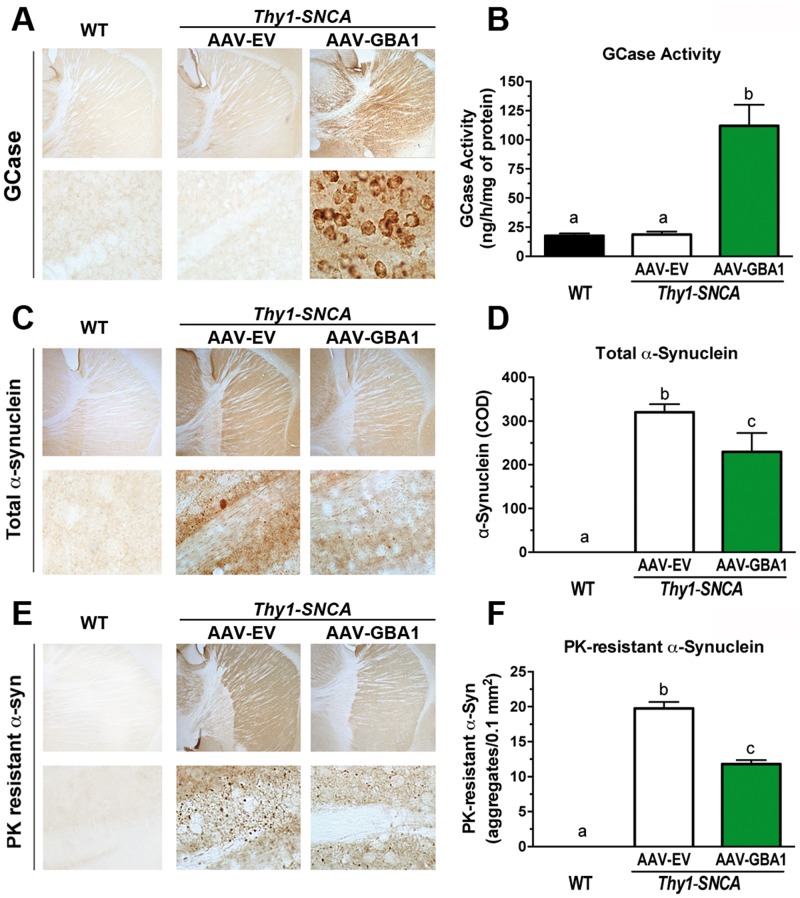
Administration of AAV1-GBA1 into the striatum of Thy1-SNCA transgenic mice reduces the levels of α-synuclein in the CNS. Two-month-old female Thy1-SNCA mice were subjected to bilateral striatal injections of 1.8e10 gc/site of either AAV1-EV (n = 16, white columns) or AAV1-GBA1 (n = 16, green columns). Uninjected, age-matched WT mice (WT; n = 16, black columns) were used as healthy controls. Tissues were collected for biochemical and pathological analysis at 7 months post-injection. Immunostaining for glucocerebrosidase showed robust striatal expression in AAV1-GBA1-injected Thy1-SNCA mice. Mice treated with a control virus (AAV1-EV) showed a low level of staining in the CNS that was similar in intensity to that in untreated WT mice. Representative pictures are shown in (A). Robust glucocerebrosidase activity was observed in AAV1-GBA1-injected striata (B, 6-fold greater than the AAV1-EV controls, n = 8 per group, p < 0.05). Increased glucocerebrosidase activity in the CNS of Thy1-SNCA mice reduced the levels of total and proteinase K-resistant α-synuclein levels. Representative photomicrographs of brain sections from the striata of WT and Thy1-SNCA mice immunostained with an anti-α-synuclein antibody without (C) and with (E) proteinase K pretreatment. Quantification of the α-synuclein signal indicated a significant reduction in total and proteinase K-resistant α-synuclein in the AAV1-GBA1 treated group. Graphs represent striatal quantification of total α-synuclein (D, n = 16 per group) and proteinase K-resistant α-synuclein (F, n = 16 per group). The results are presented as the mean ± SEM. Bars marked with different letters are significantly different from each other (p < 0.05).